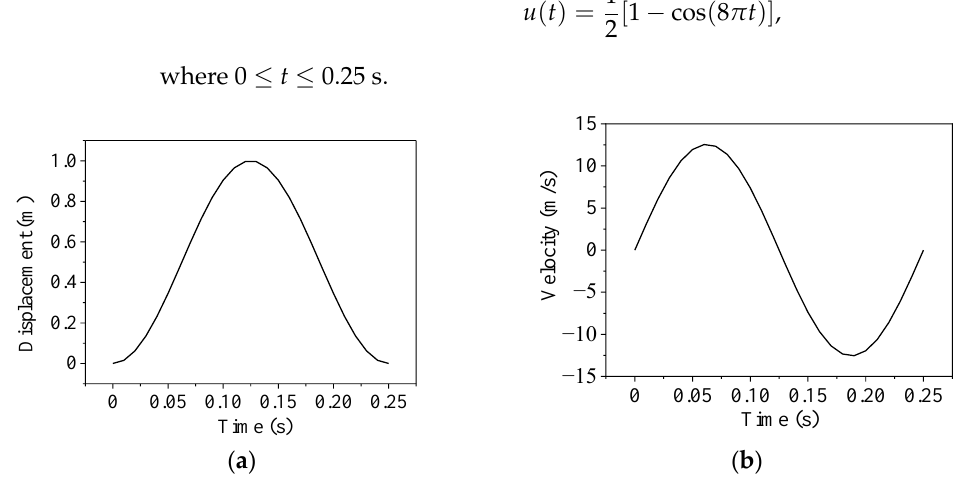
Figure 4. Plane SV wave pulse of oblique incidence: ( a ) displacement; ( b ) velocity.